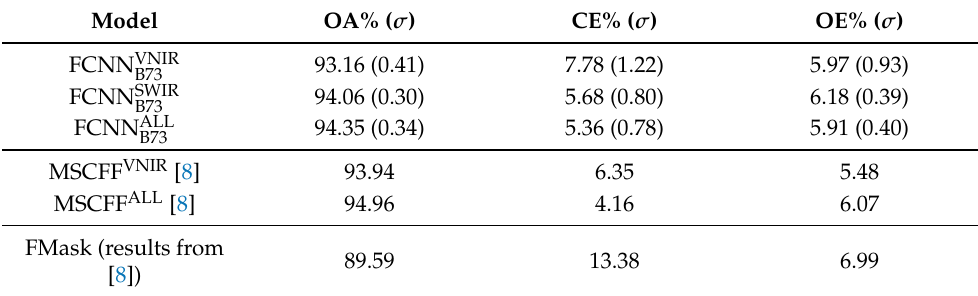
Table 3. Results of FCNN B73 (with and without SWIR bands), FMask, and MSCFF [8] evaluated on 19 test images from the L8-Biome